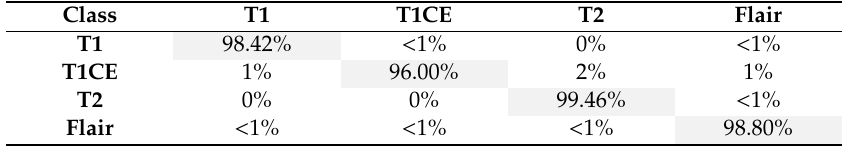
Table 2. Confusion matrix of the proposed method for the BraTS 2017 dataset (Proposed).